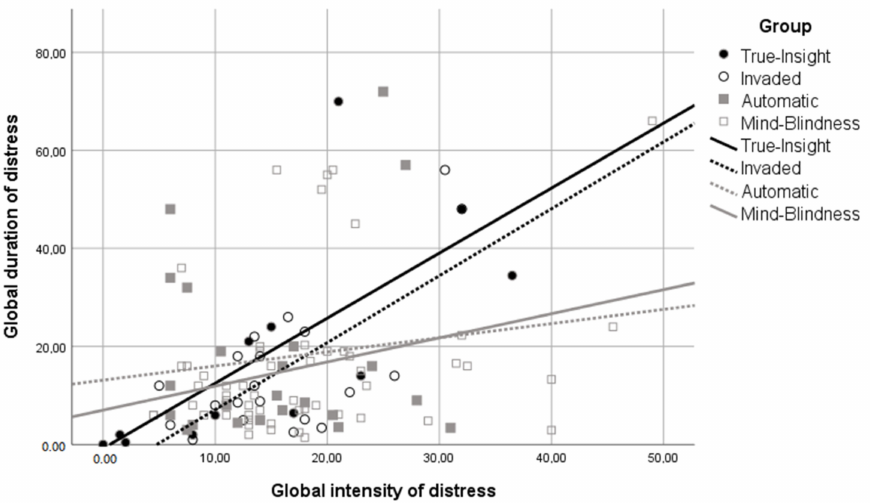
Figure 2. Grouped scatterplot of global duration (weeks) of distress and global intensity of